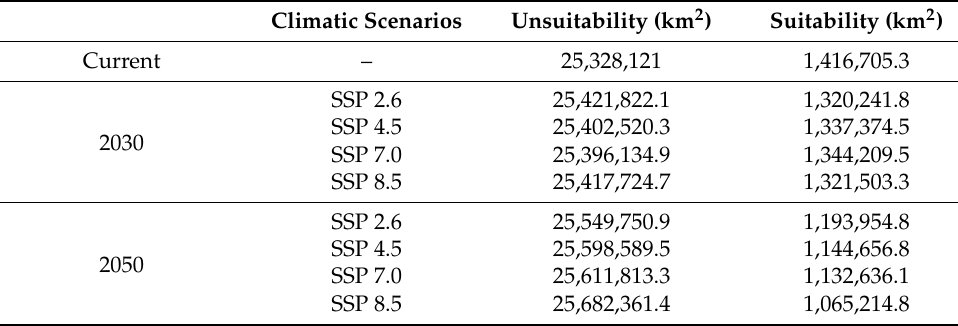
Table 8. Predicted suitable areas under the current and future climatic conditions during October– December